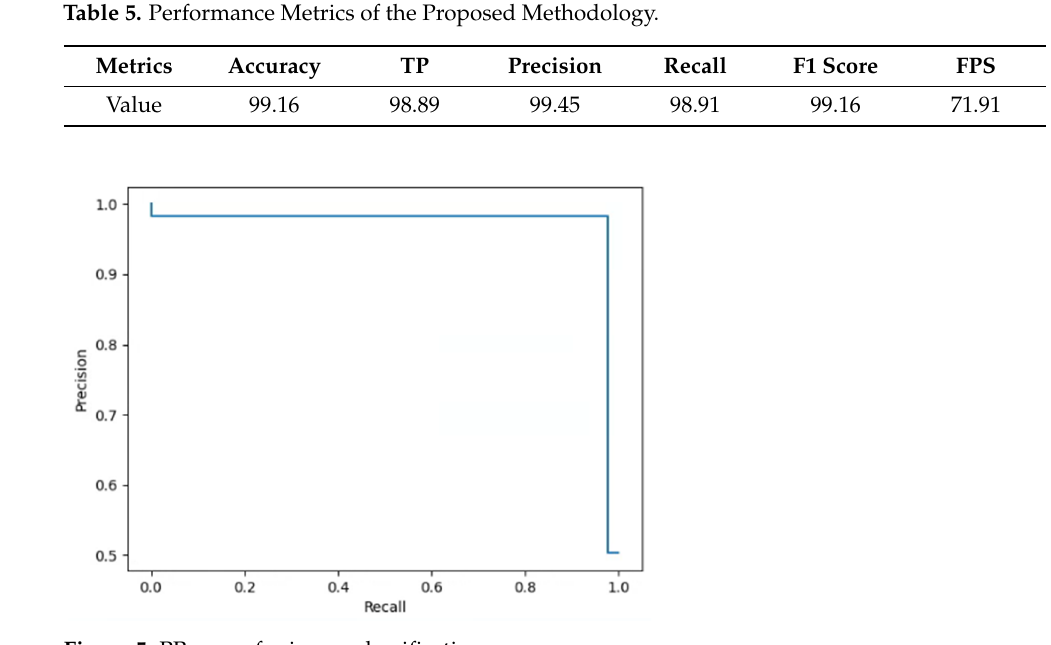
Figure 5. PR curve for image classification.